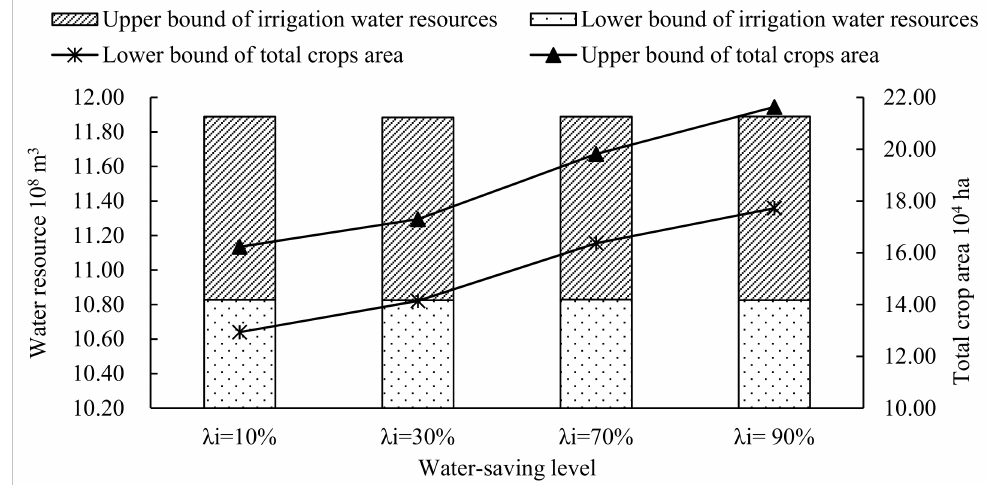
Figure 9. Irrigation water resource consumption and total crop area of di ff erent water-saving modes at violation probability P i =